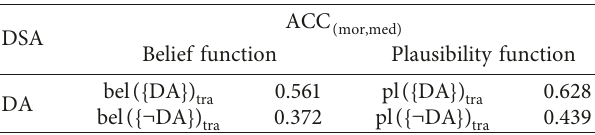
Table 11: Belief values of DA with one activated sensor combined with mobility